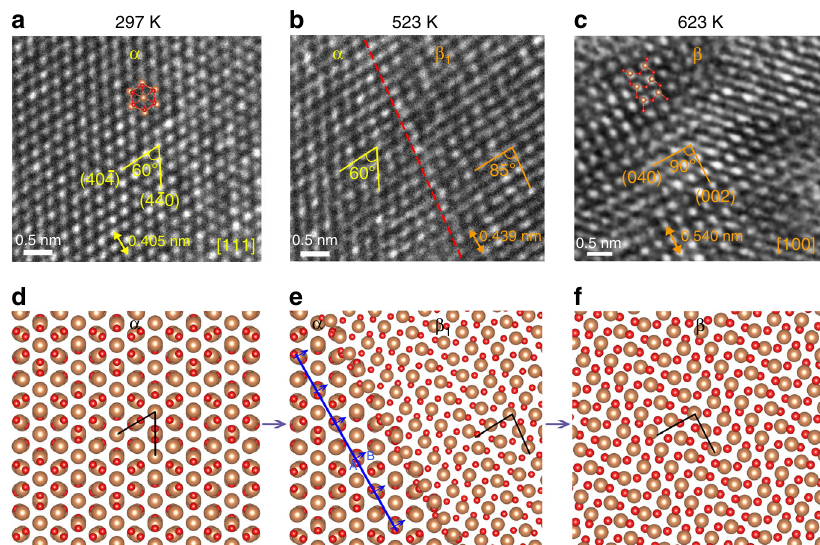
Fig. 7 Atomic mechanism of structural evolution in Sb 2 O 3 fl ake at elevated temperatures. a HRTEM image of α - phase with (111) top plane at room temperature. b At 523 K, an intermediate phase forms (denoted β 1 ) with plane angle of 85° and a phase boundary appears. c At 623 K, β -phase forms with plane angle of 90° and top plane of (100). d − f Atomic models of the α → β phase transition corresponding to the TEM images in ( a − c ),